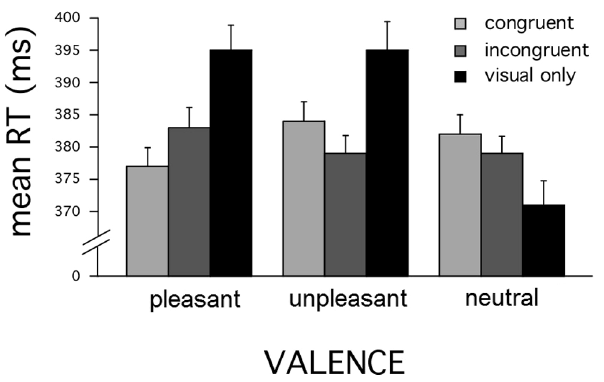
Figure 2. Overview of findings in Experiment 2 (visual classification). Average response times as a function of emotional valence (pleasant, neutral, unpleasant pictures) in the visual scene and of crossmodal congruence. Error bars: 1